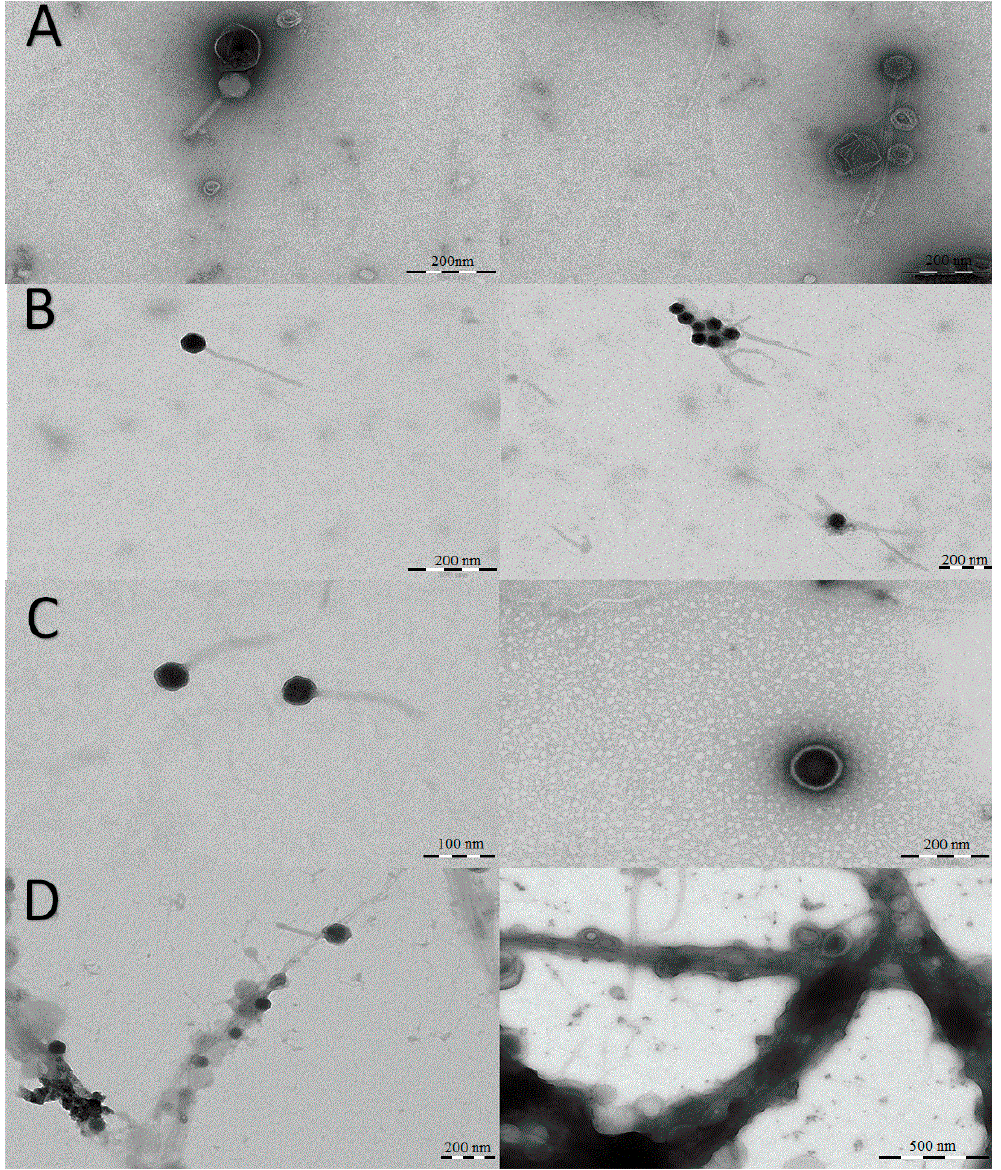
Figure 1. The most representative viral morphologies observed in influent urban wastewater (Line A ), mixed liquor (Line B ), effluent treated water (Line C ), and sludge excess (Line D ) of the Los Vados WWTP.